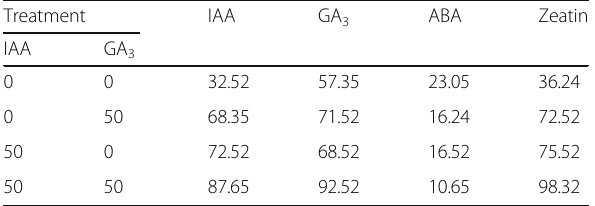
Table 4 Effect of IAA and/or GA endogenous phytohormones ( μ g/100 g Fresh wt) of mungbean plants grown under sandy soil